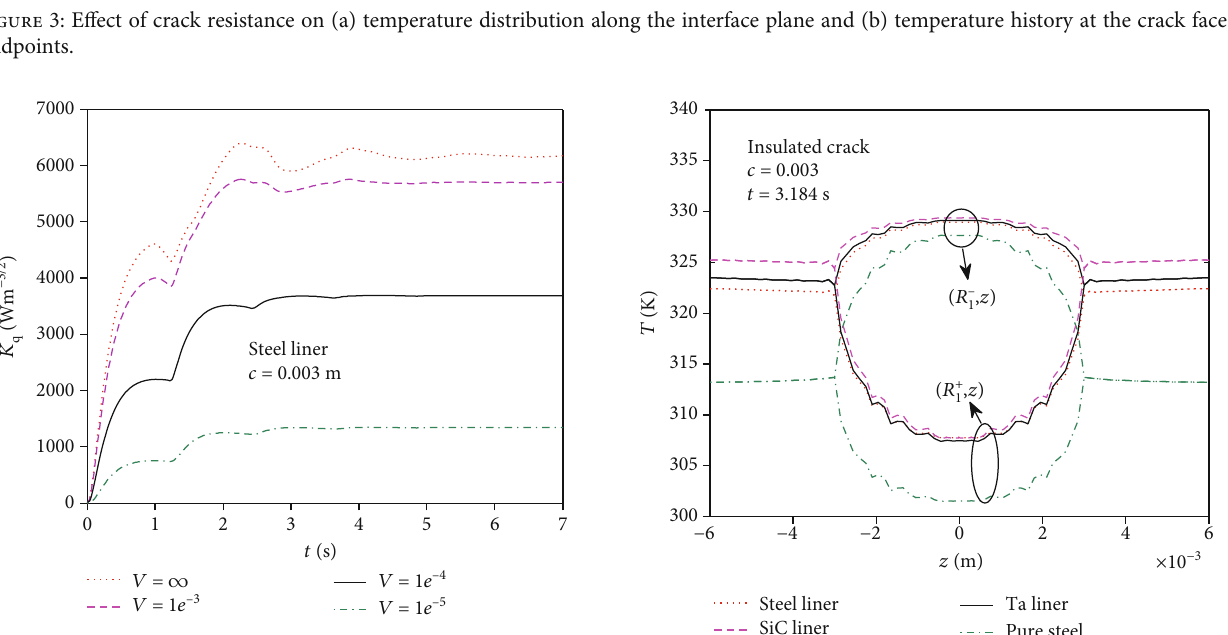
Figure 4: E ff ect of crack resistance on the HFIF history.